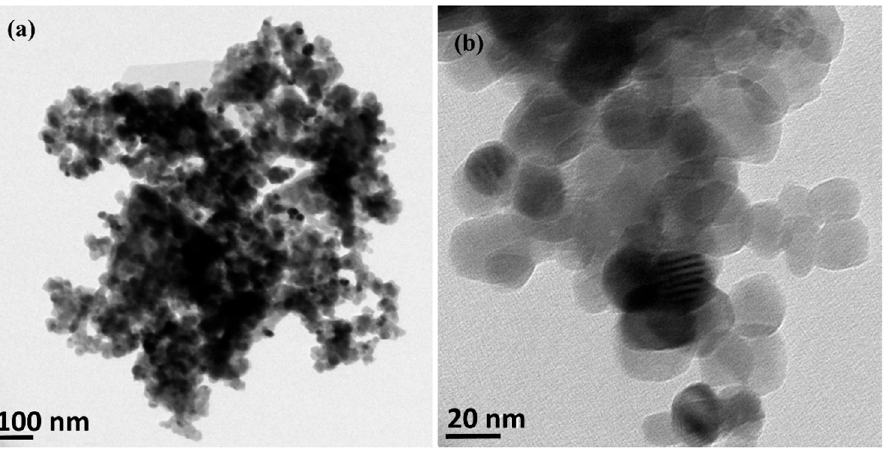
Figure 5. ( a ) Low and ( b ) High resolution TEM images showing the morphology of as-synthesized ZnO nanoparticles.